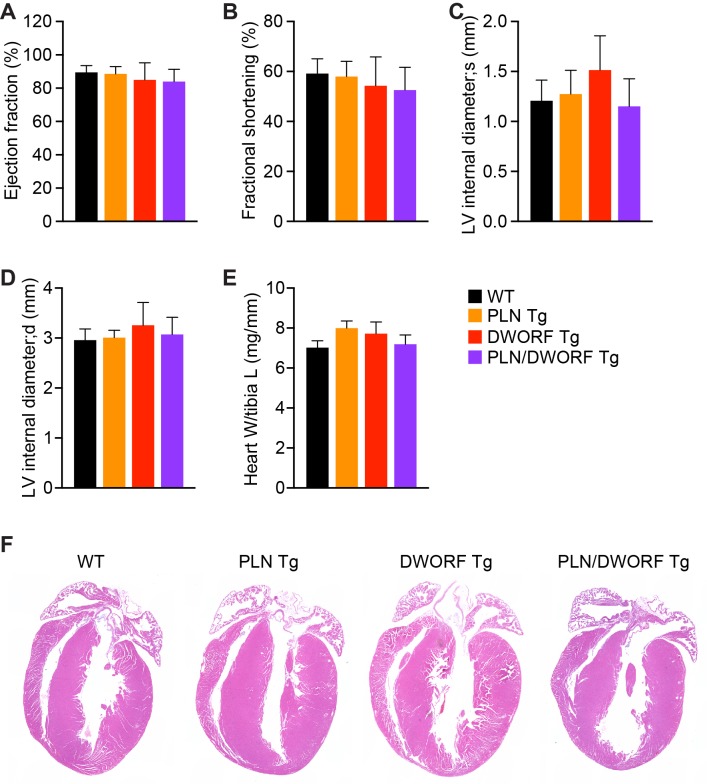
Cardiac function and histological analysis of PLN/DWORF Tg mice.Cardiac function was calculated from M-mode echocardiographic tracings of 12- to 16-week-old mice with the indicated genotypes and is represented as mean ejection fraction (A) and fractional shortening (B). M-mode images were also used to calculate cardiac dimensions and are represented as left ventricular (LV) internal diameter during maximal contraction (systole, s) (C) and relaxation (diastole, d) (D). Data are expressed as mean ±SD for n = 4–8 mice per genotype. (E) Heart weight (W) to tibia length (L) measurements from n = 4 mice per genotype. Data are represented as mean ±SD. (F) Representative hematoxylin and eosin (H and E) staining of four-chamber histological sections of 16-week-old mice with the indicated genotypes.